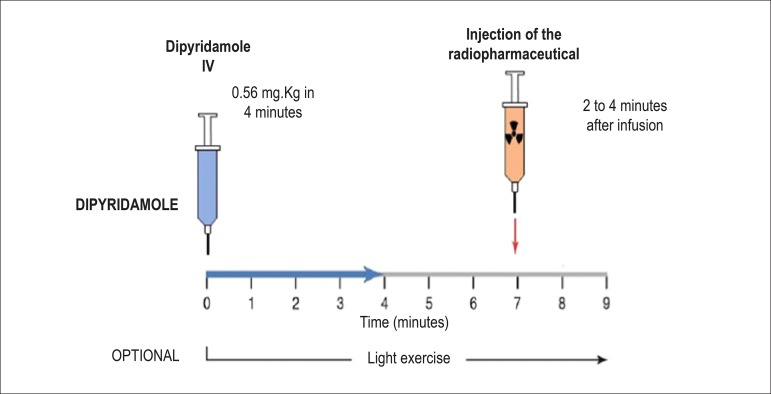
Myocardial perfusion scintigraphy associated with injection of dipyridamole. The moment of maximum vasodilation or coronary hyperemia occurs between 2 and 4 minutes after completing intravenous dipyridamole administration (blue arrow, 4 minutes), at which point the radiopharmaceutical (99mTc-tetrofosmin or MIBI-99mTc, orange arrow) is injected. Clinical observation should be continuous throughout the exam, registering blood pressure, heart rate, and electrocardiogram every 2 minutes or in accordance with medical decision, with a typical total exam time of 9 to 10 minutes.24,46